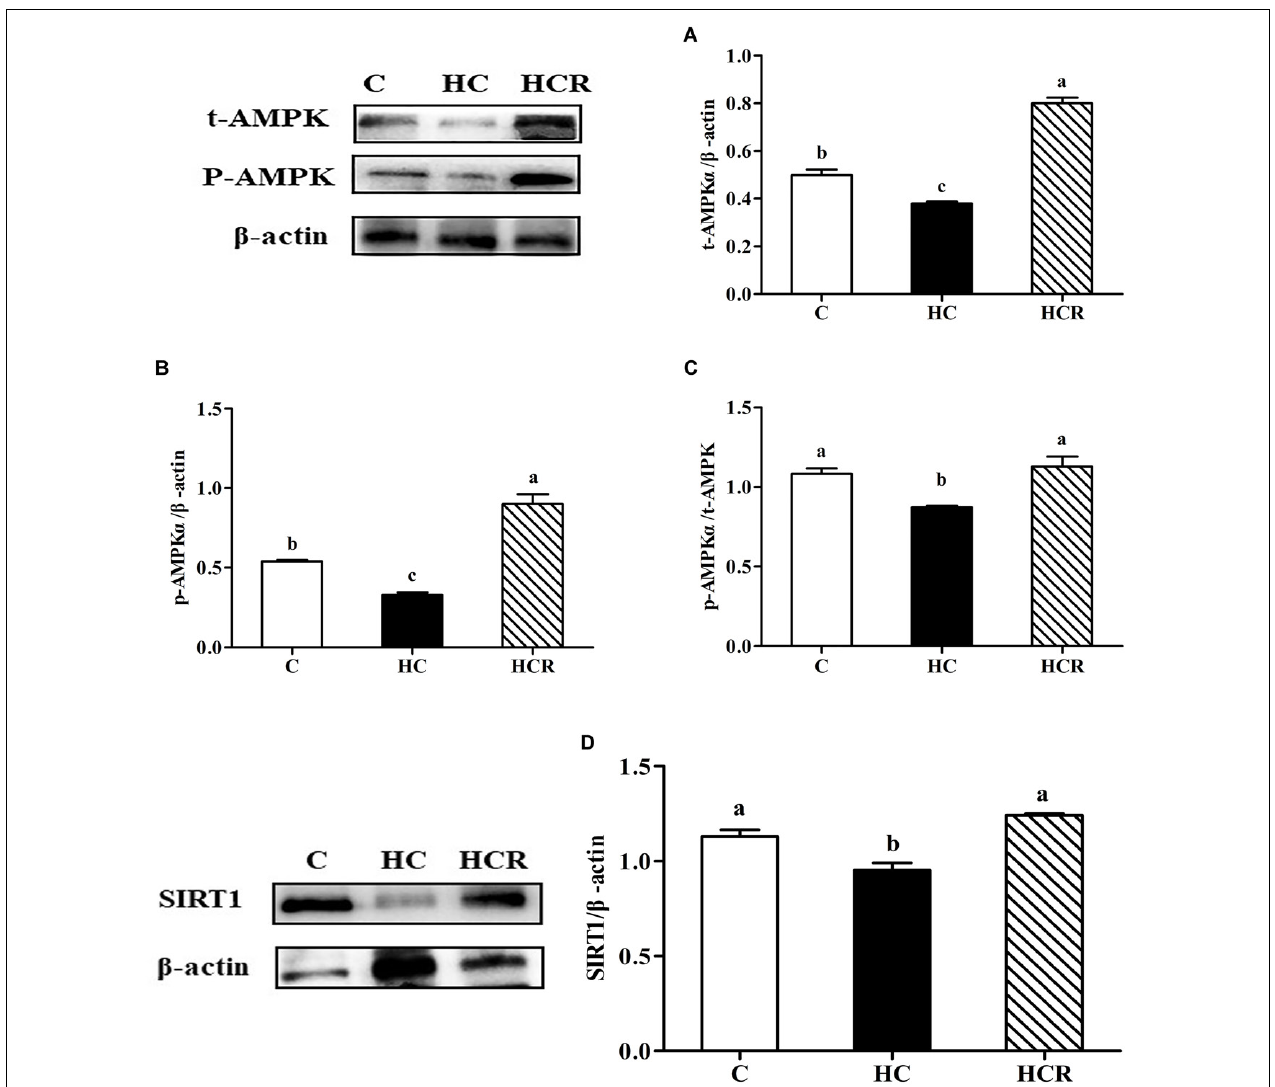
FIGURE 2 | Hepatic t-AMPK α contents (A) , p-AMPK α contents (B) , the pAMPK α /t-AMPK α ratio (C) and SIRT1 contents (D) of blunt snout bream liver fed different experimental diets. Gels were loaded with 20 µ g total protein per lane. Protein and phosphorylation levels were normalized to liver β -actin levels. Each data represents the mean of four replicates. Bars assigned with different letters are significantly different ( P < 0.05). Control, diet with 30% carbohydrate level; HC, diet with 41% carbohydrate level; HCR, diet with 41% carbohydrate and 0.04% resveratrol. t-AMPK α , AMP-activated protein kinase α ; phosphorylated AMP-activated protein kinase α ; SIRT1,